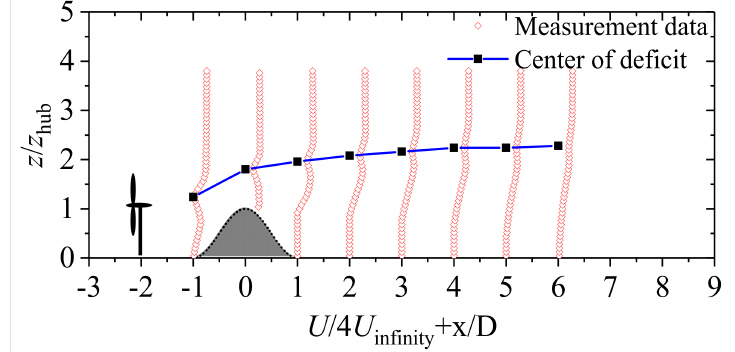
Figure 10. Wind turbine wake distributions when sited 2D in front of the test hill (case 3).